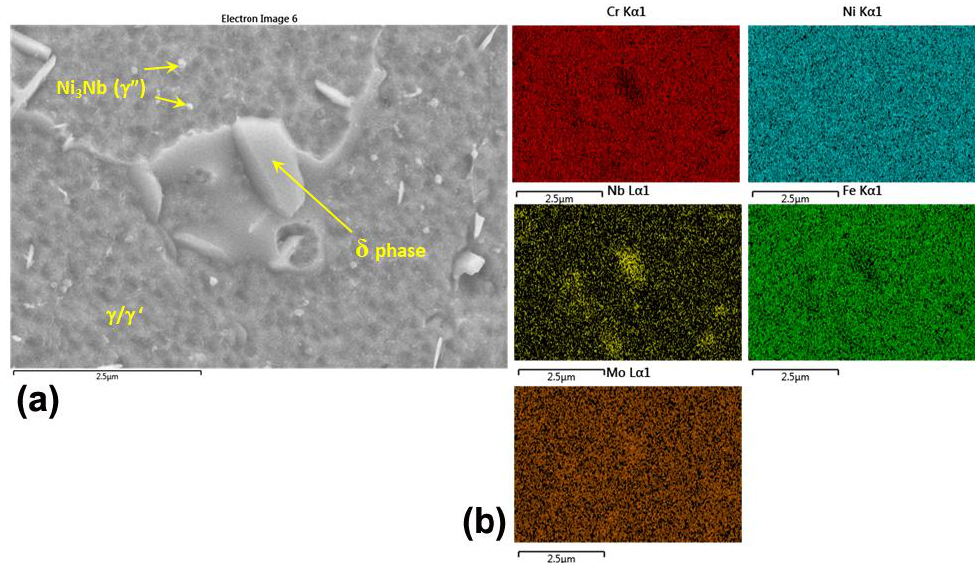
Figure 13. FESEM micrograph for IN718 alloy with modified heat treatments (polished samples, ( a ): Y-axis sample with TT1 (25,000X, left), and ( b ): the respective X-ray elemental maps through EDS (right).